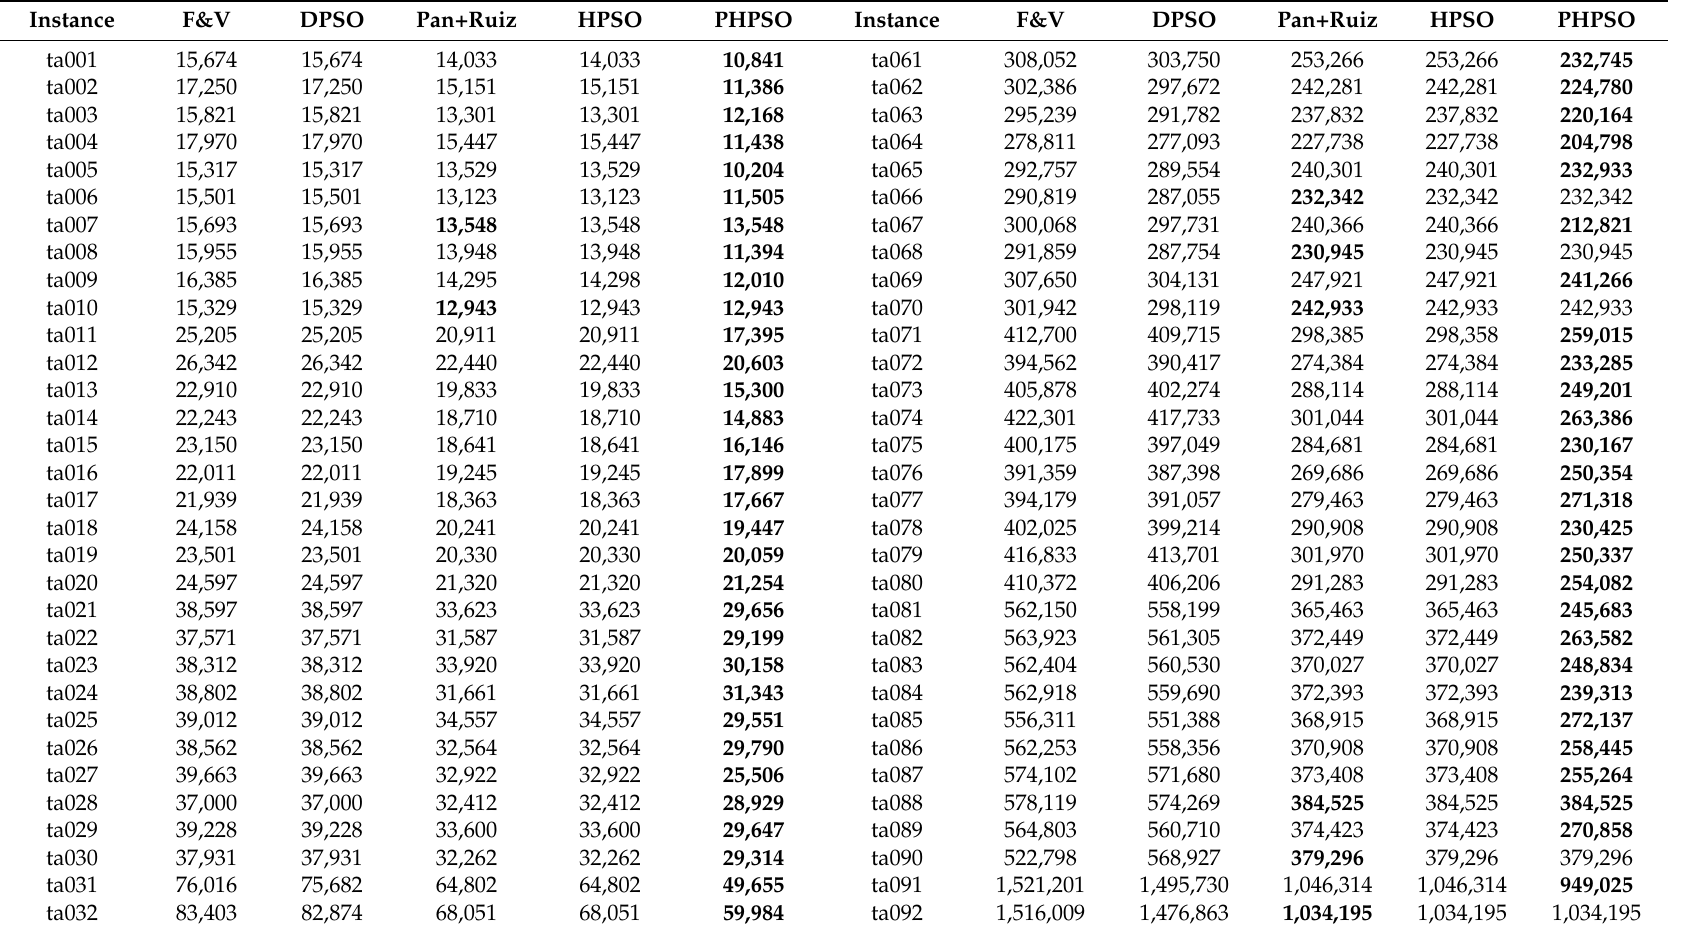
Table 10. New objective function values for Taillard’s benchmarks treated as NWFSS with TFT